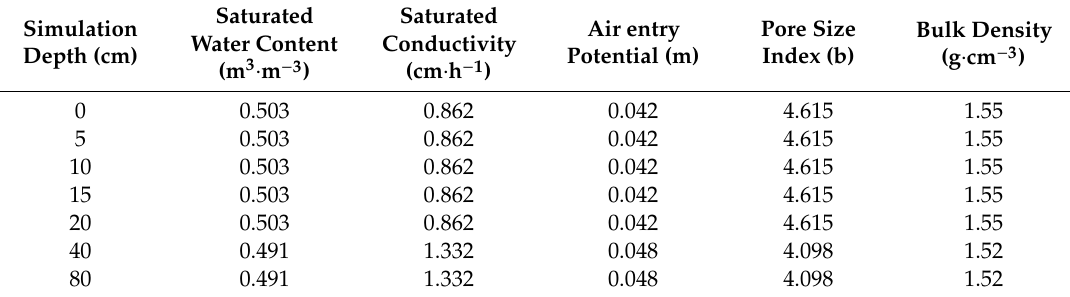
Table 2. Optimized soil profile parameters.